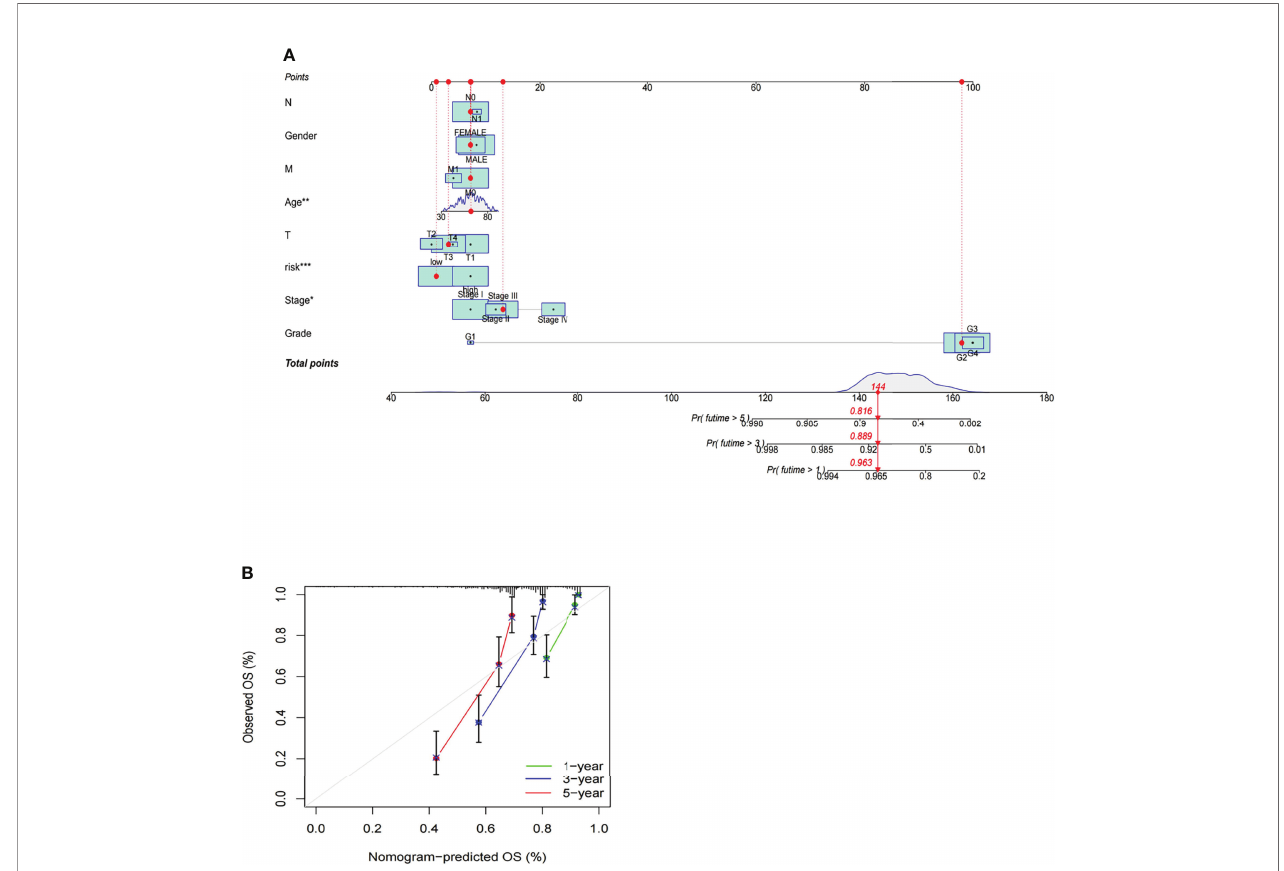
FIGURE 10 | Construction and evaluation of a prognostic nomogram. (A) The likelihood of the 1-, 2-, and 3-year OS predicted by the nomogram. (B) The likelihood of the 1-, 2-, and 3-year OS predicted the calibration plot of the